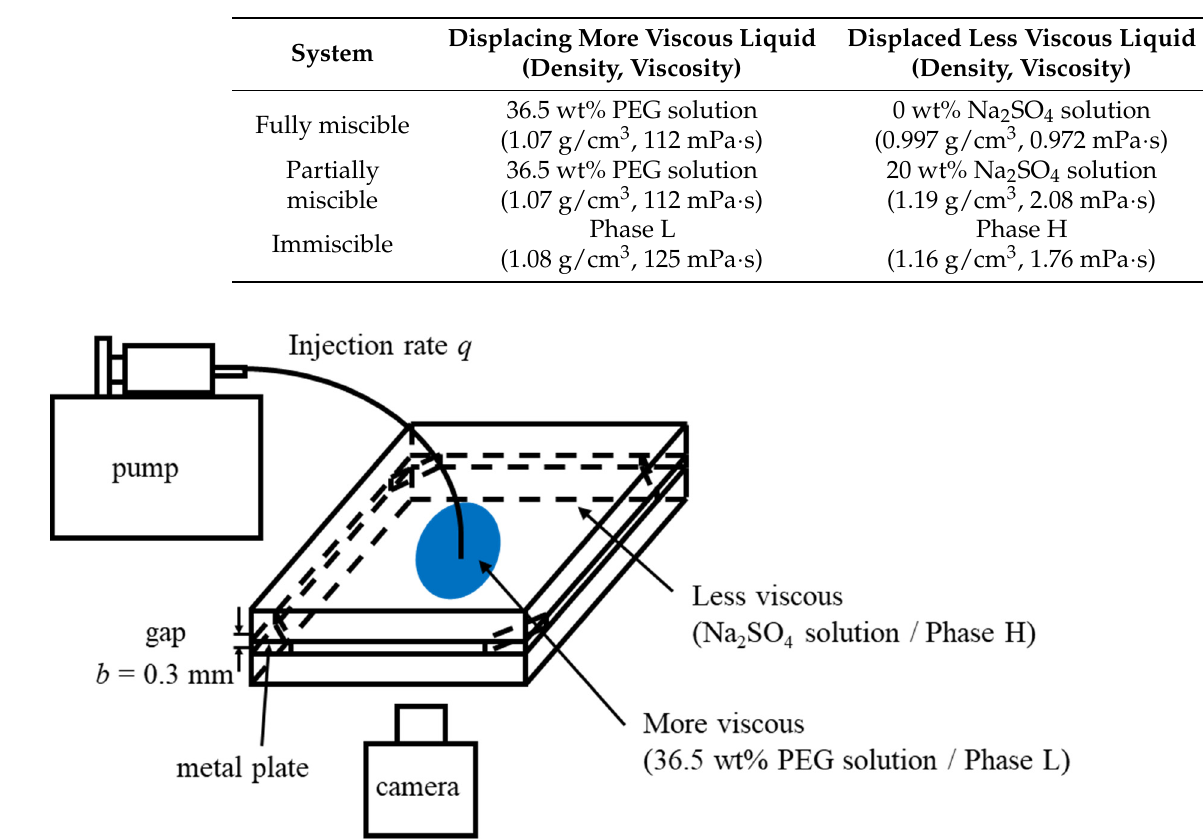
Table 1. Physicochemical properties of the considered system.